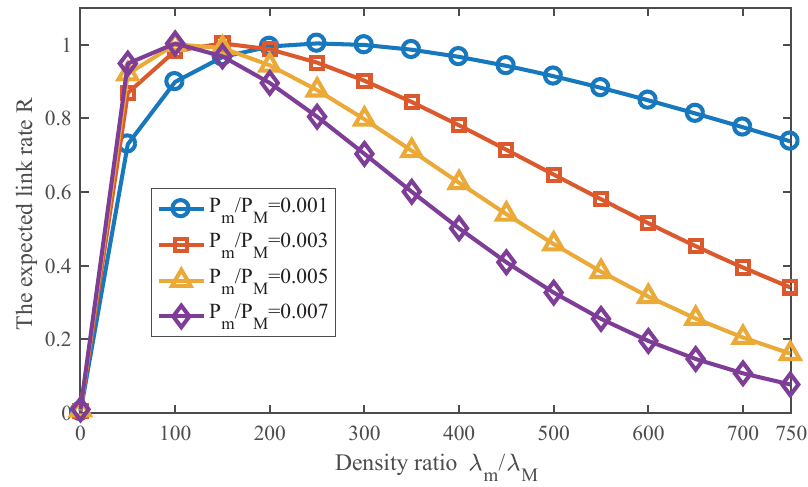
Figure 5. The effect of SmBS density on the link rate under different SmBS transmit